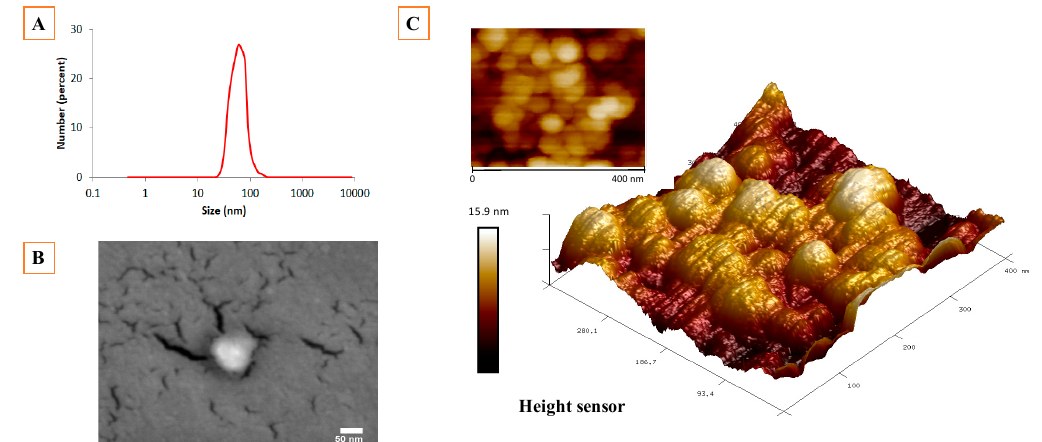
Figure 2. Z-average size (number-based distribution) of AstaCO 2 -NLC measured by DLS ( A ). SEM image of AstaCO 2 -NLC (scale bar 50 nm) ( B ). AFM images of AstaCO 2 -NLC in both topographic mode and 3D mode ( C ).